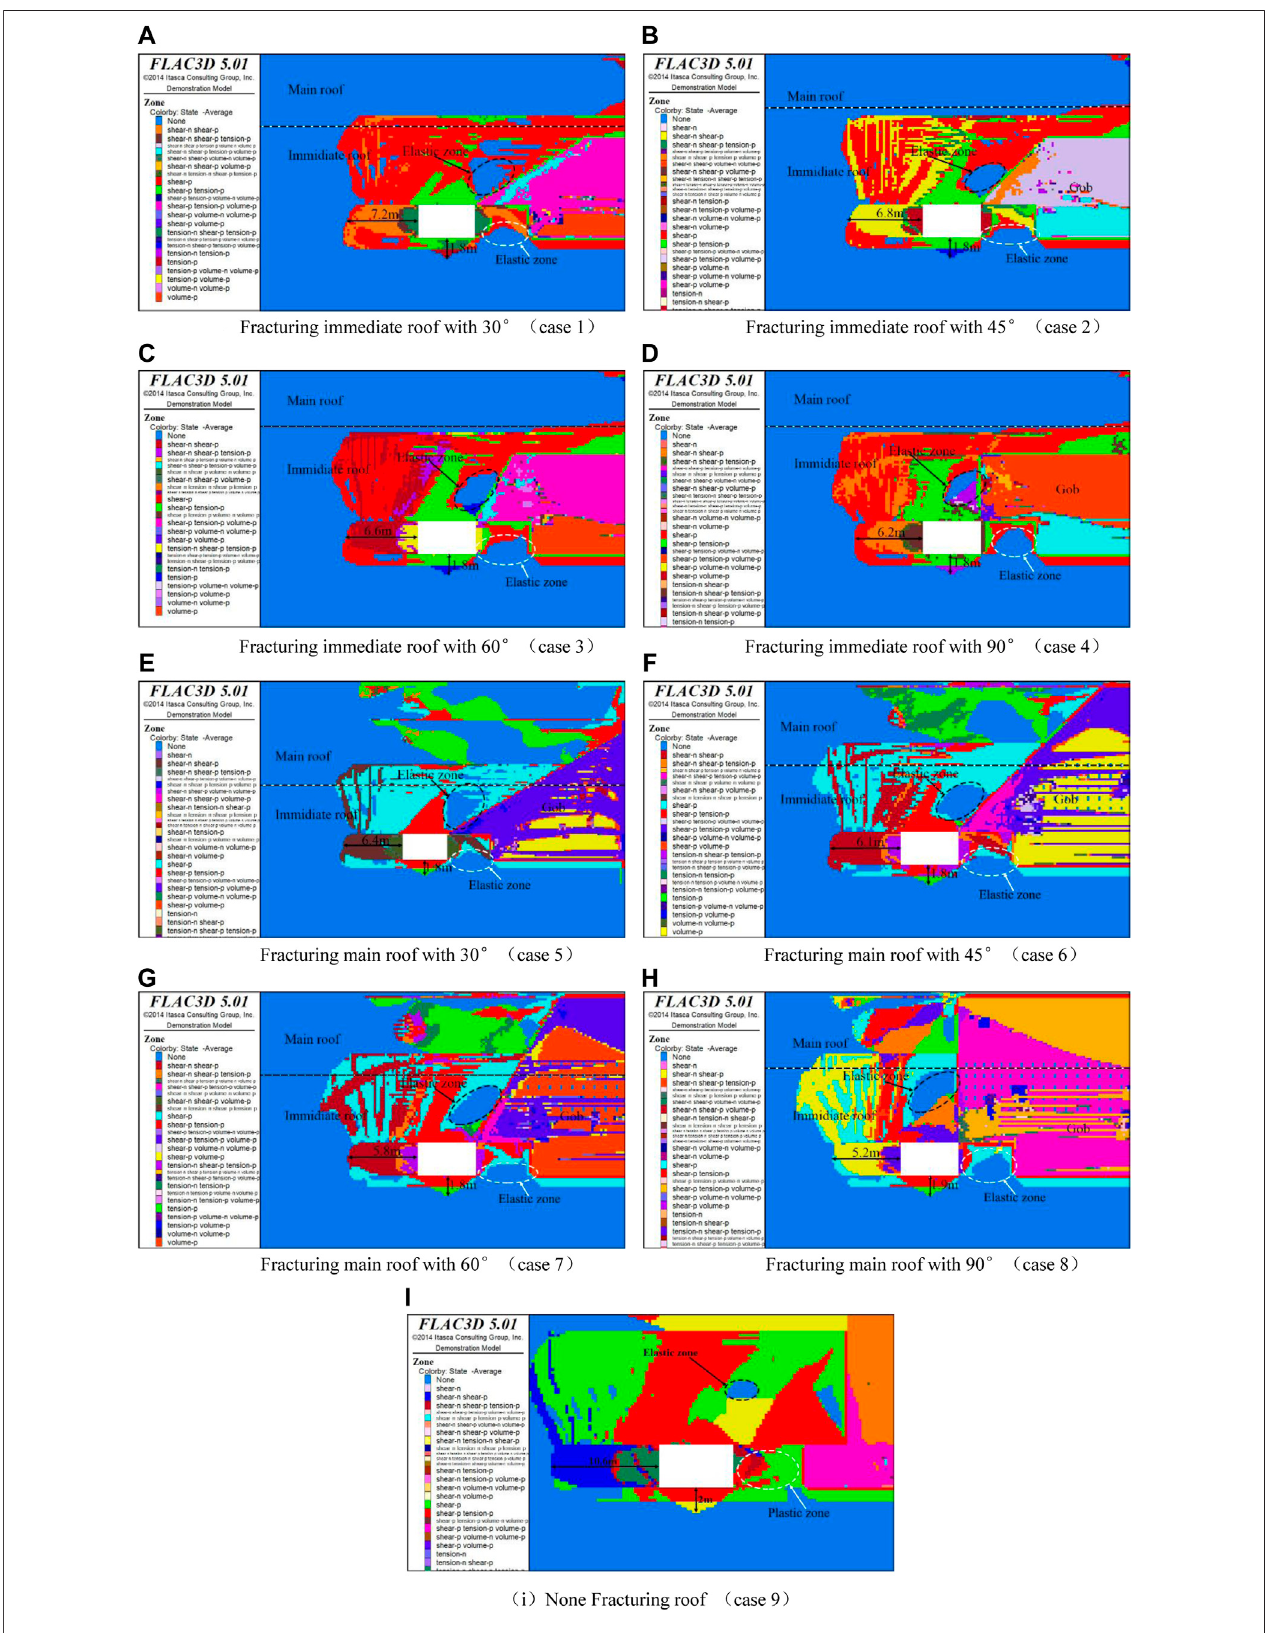
FIGURE 12 | Distribution of the plastic zone in the surrounding rock of the roadway with different roof cutting schemes. (A) Fracturing the immediate roof with Frontiers in Earth Science |